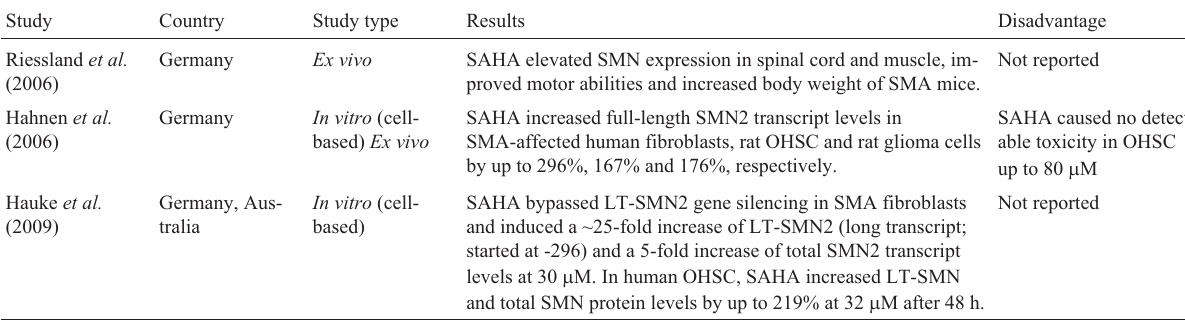
Table 6 - Summary of studies on SAHA for the treatment of spinal muscular atrophy.